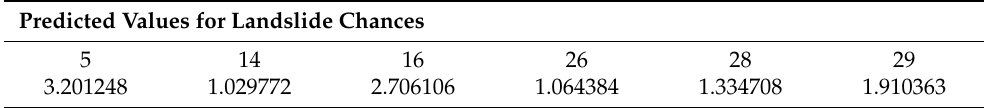
Table 6. Modelled values for landslide chances using MLR. Predicted Values for Landslide Chances